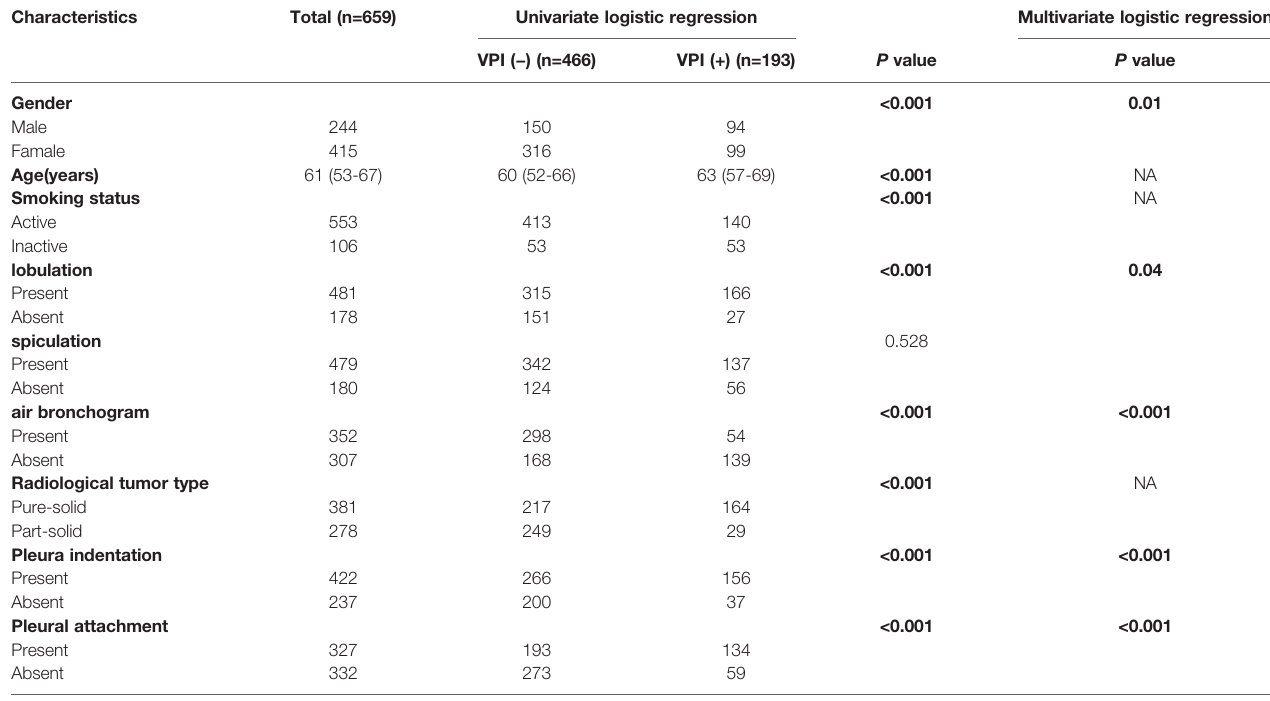
TABLE 1 | Characteristics of 659 lung adenocarcinoma patients, according to the presence of the visceral pleural invasion. Characteristics